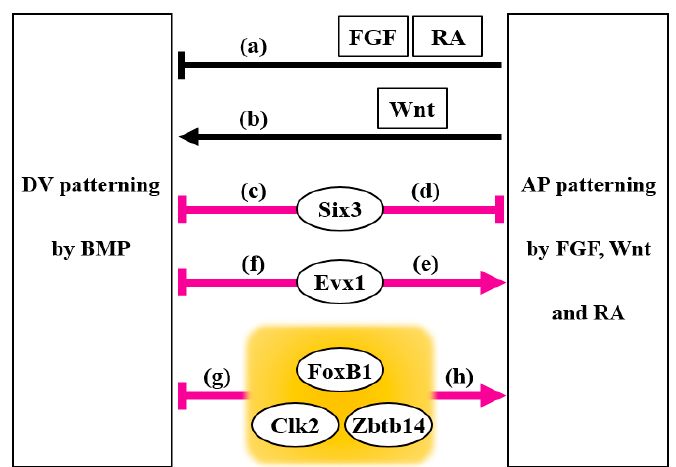
Figure 2. Interconnected regulatory pathways in the control of DV and AP axis formation. BMP Figure2. InterconnectedregulatorypathwaysinthecontrolofDVandAPaxisformation. BMPsignaling determines the DV axis by inducing ventral fate, while the AP patterning is controlled by the FGF, Wnt, and RA signaling pathways. ( a ) FGF and RA inhibit BMP signaling by promoting Smad1 / 5 /